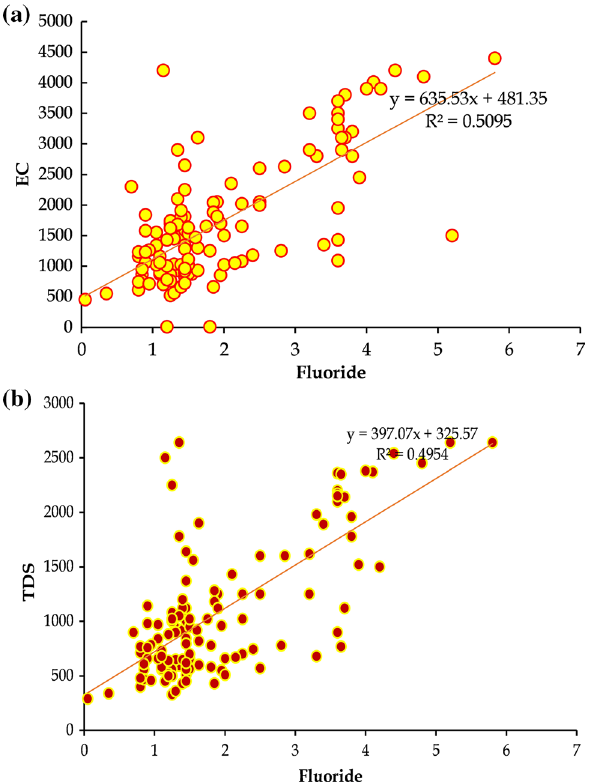
Fig. 7 Correlation between a fluoride and EC, and b fluoride and TDS in the groundwater of Markapur, India